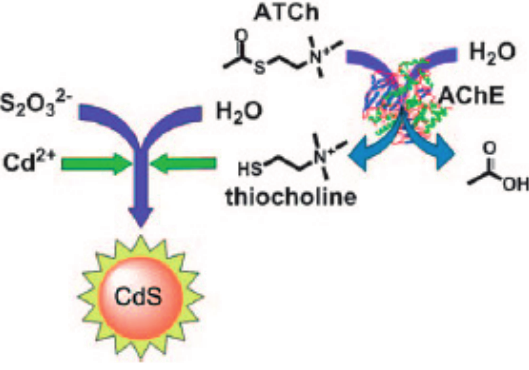
Figure 4. Enzymatic generation of CdS QDs for the detection of AChE activity. Reprinted with permission from [22]. Copyright 2010 John Wiley and